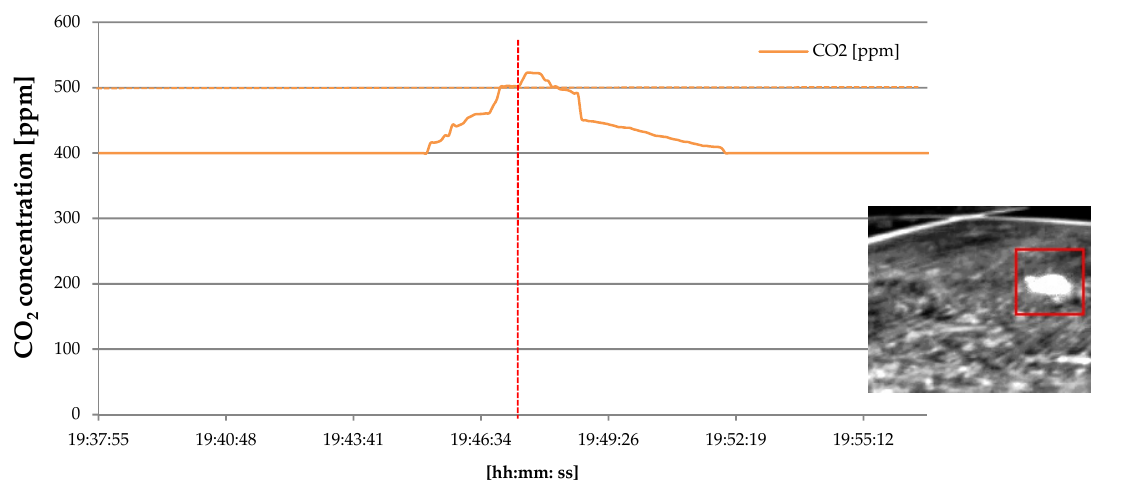
Figure 9. CO 2 trend acquired during the third test campaign used to test the functionality of the IR camera and visual recognition algorithm.